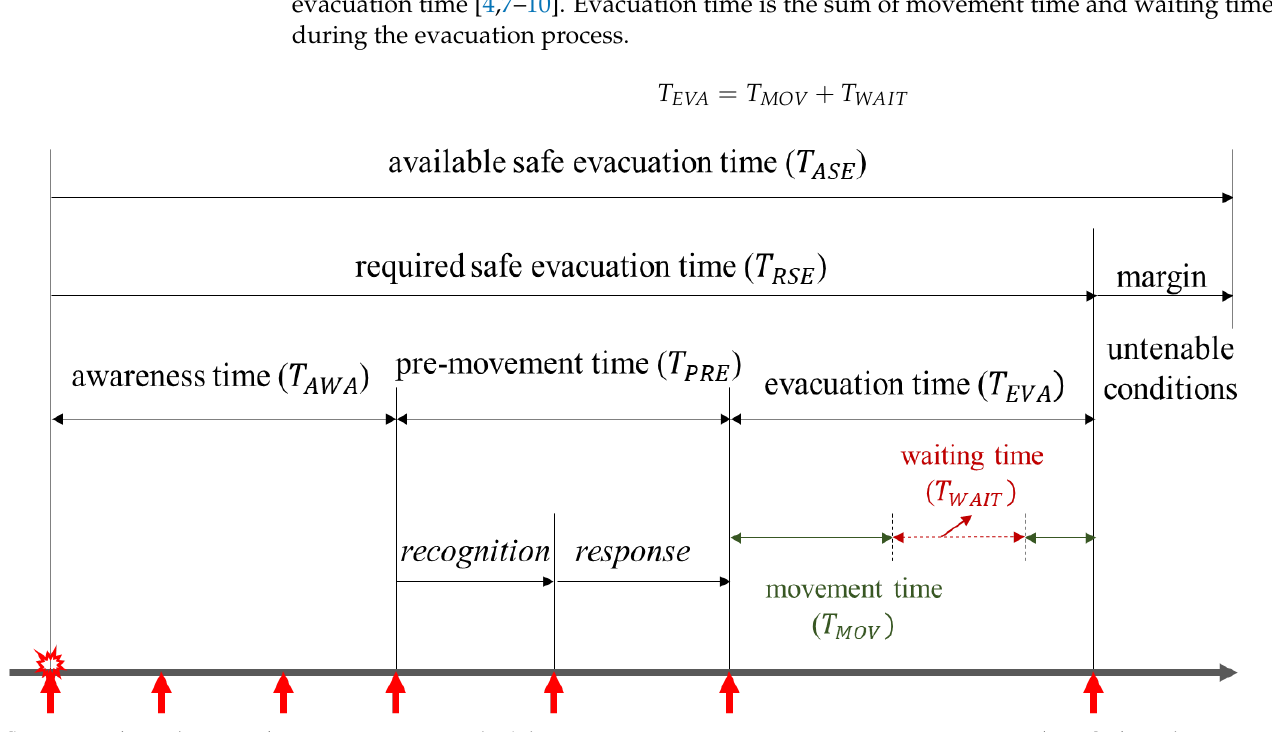
Figure 1. The composition of evacuation time: fire start: ignition (the point when a fire starts); detection: the point when the detection systems are activated; i.e., sprinklers; alarm: the point when